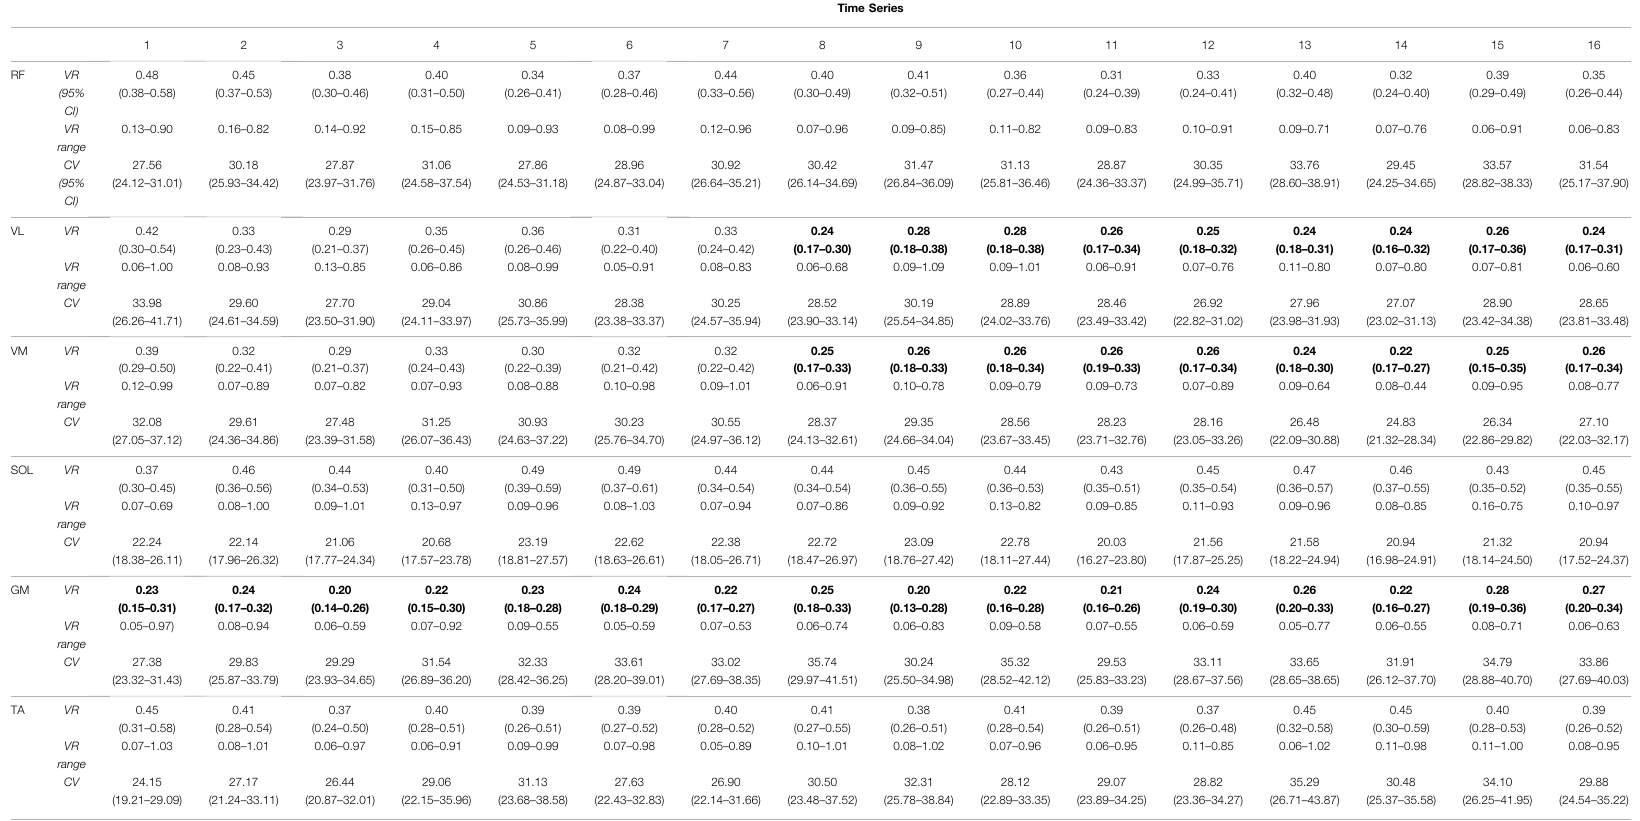
TABLE 1 | Group mean data for VR (95% CI range), VR ranges and CV (95% CI ranges) for time series are presented for all analyzed